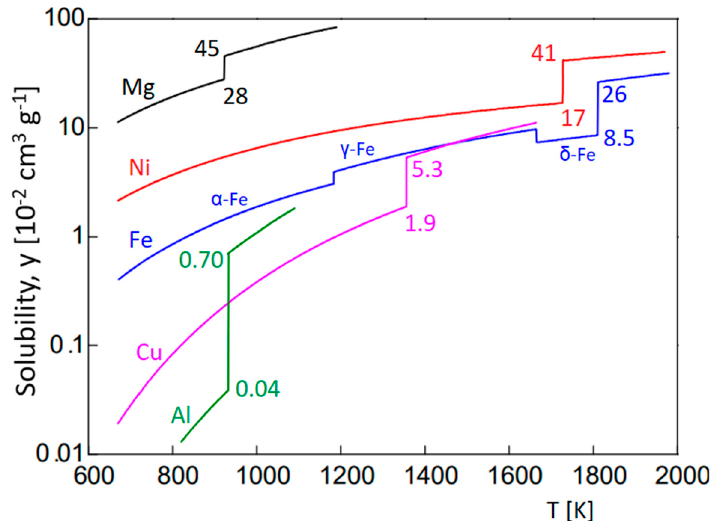
Figure 1. Hydrogen solubility in various solids and melts. Note that temperature is expressed in Kelvin. Adapted according to [19]. Copyright (2004) The Japan Society of Applied Physics.